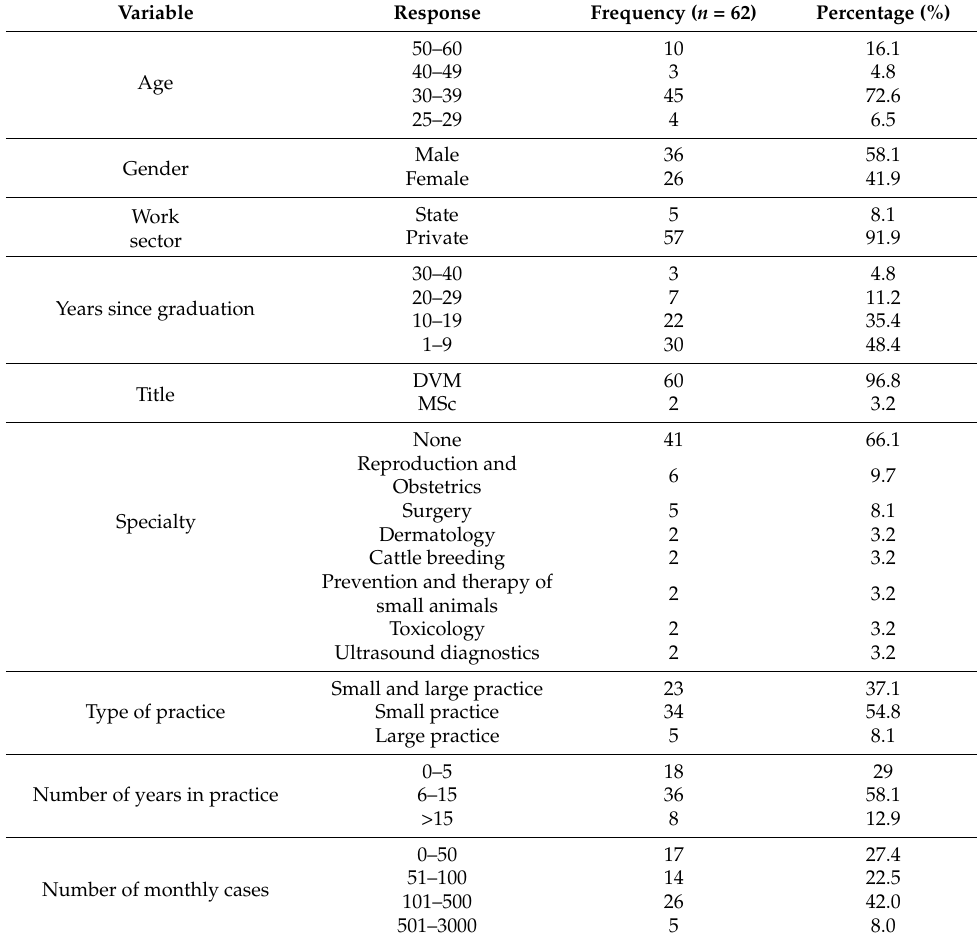
Table 1. Sociodemographic